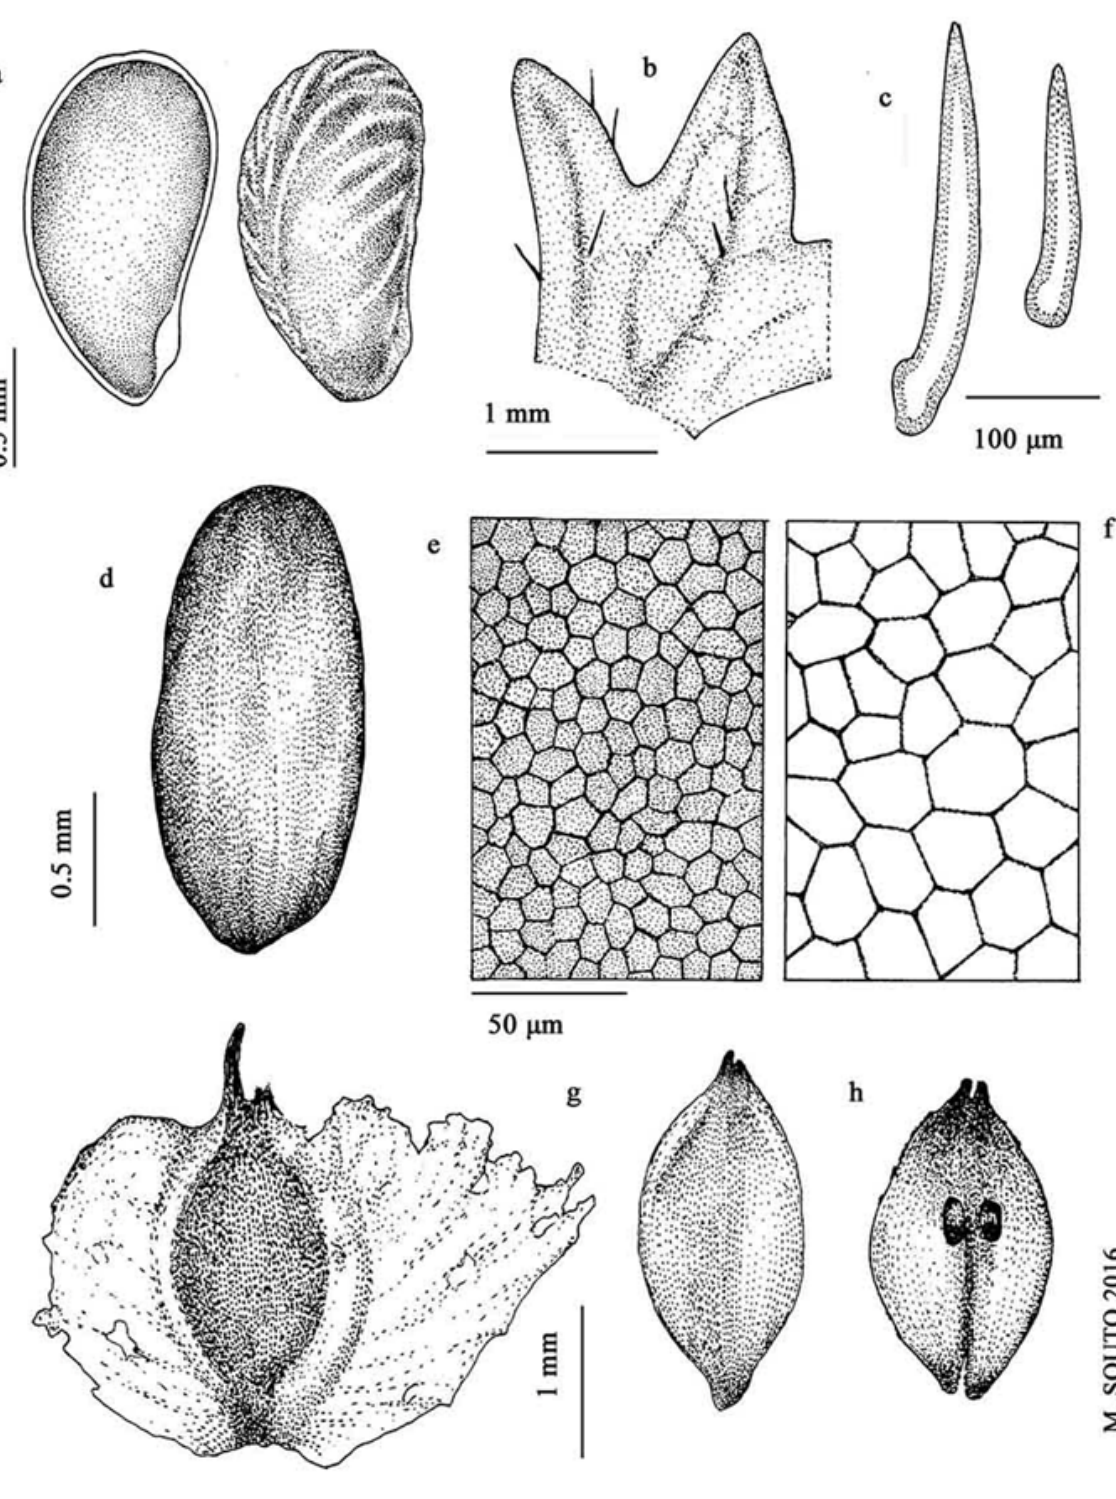
Figure A7. Potentilla erecta : a) achenes; b) leaflet fragment; c) leaflet hairs. Caltha palustris : d) seed; e) outer testa cells; f) inner testa cells. Betula alba : g) fruit with wings (samara); h) fruits which have lost their